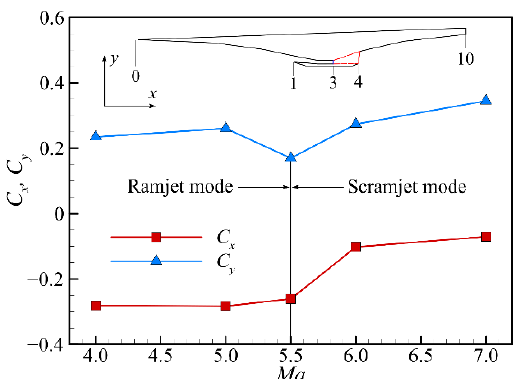
Figure 14. Horizontal and vertical force coefficients at varying Mach numbers.